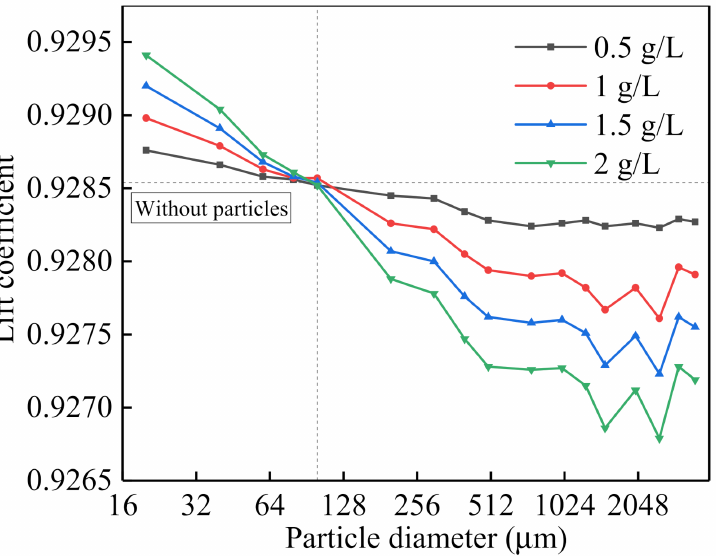
Figure 11. The airfoil lift coefficient with the particle diameter under different particle concentrations.